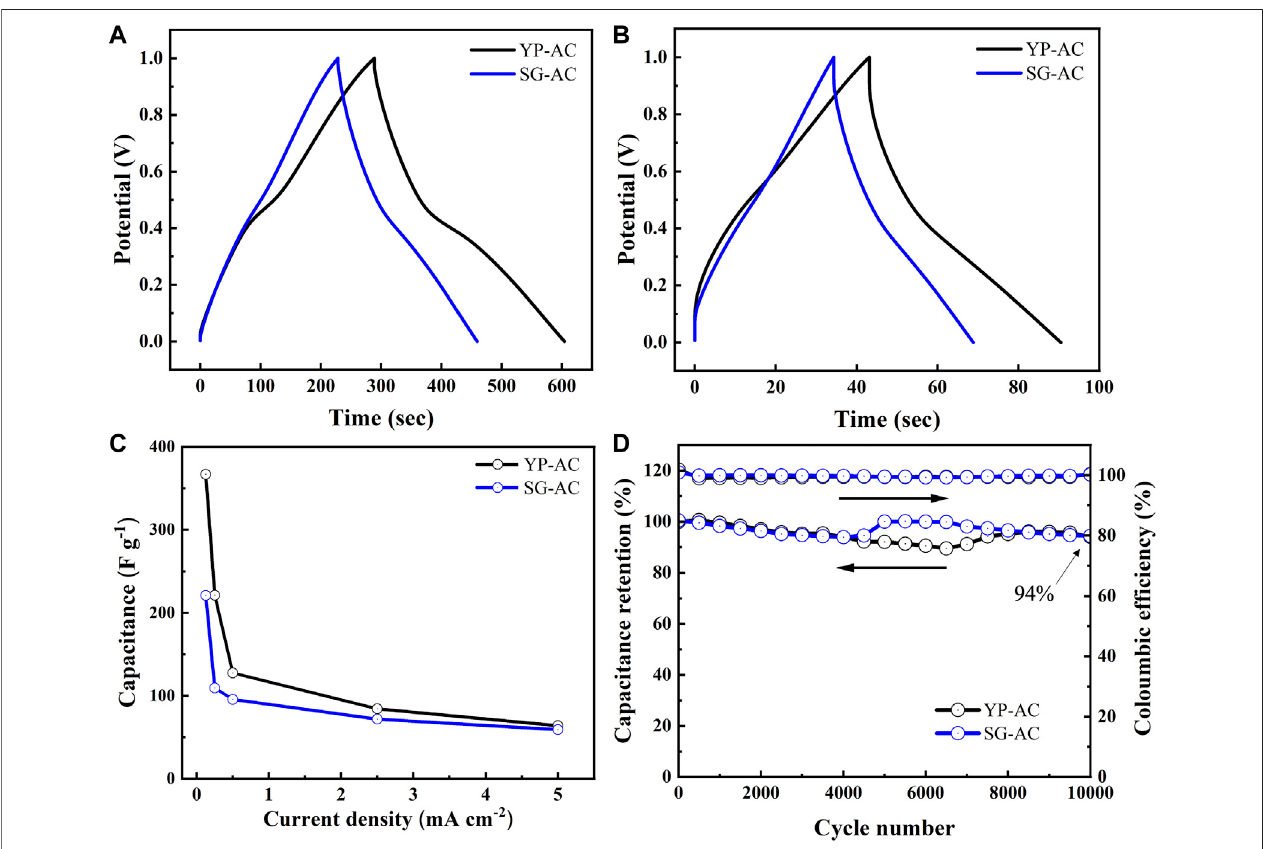
FIGURE 8 | Charge-discharge curves of different capacitors at (A) 0.5 and (B) 2.5 mA cm − 2 , (C) variation of speci fi c capacitance with current density, and (D) cyclic performance of different capacitors at 10 mA cm − 2 .